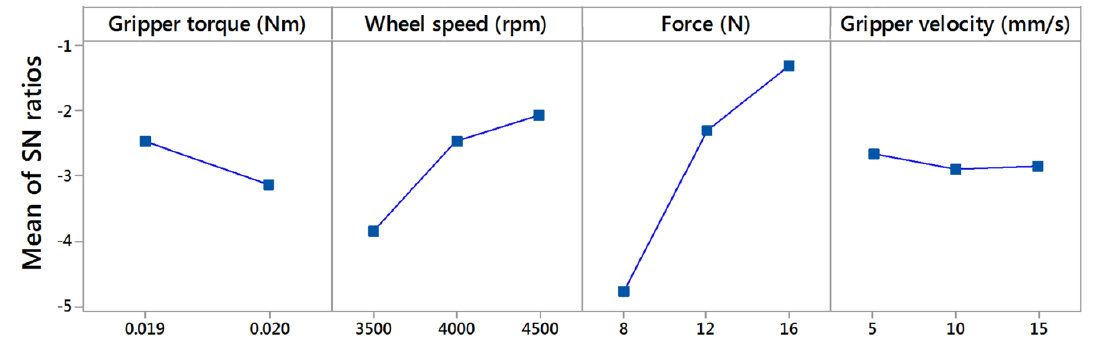
Figure 6. Main e ff ects plot of SN ratios for polishing e ffi ciency. Figure 6. Main effects plot of SN ratios for polishing efficiency. Figure 6. Main effects plot of SN ratios for polishing efficiency.